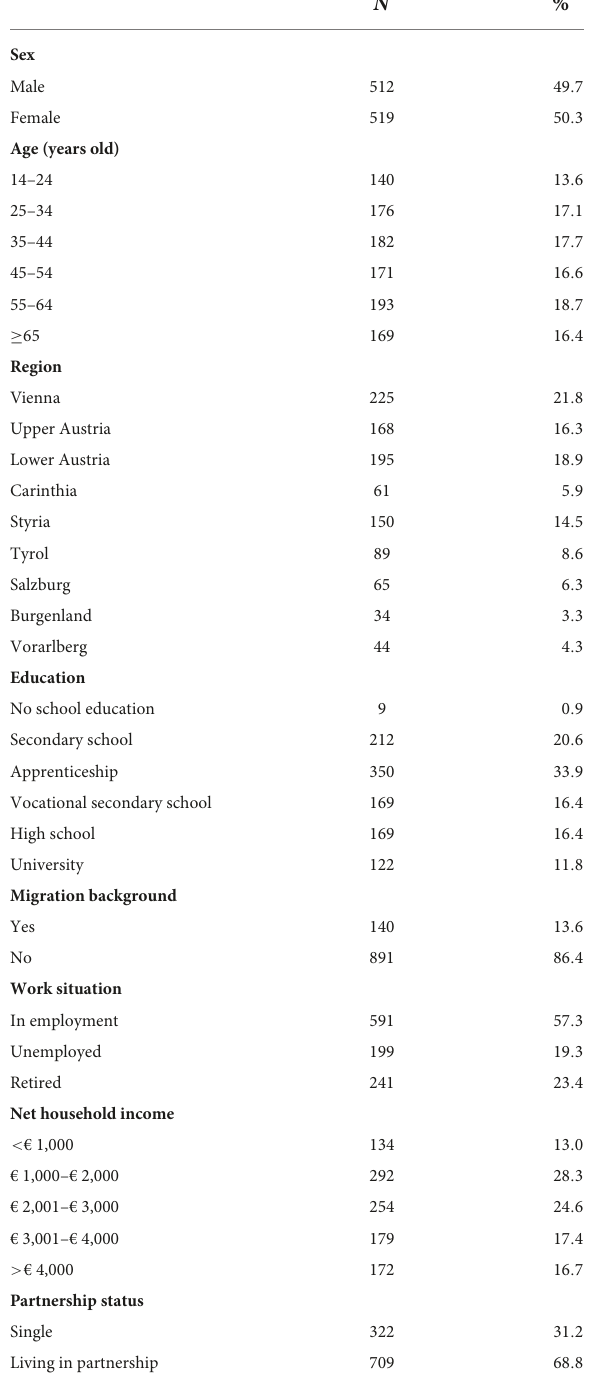
TABLE 1 Study sample characteristics ( n =